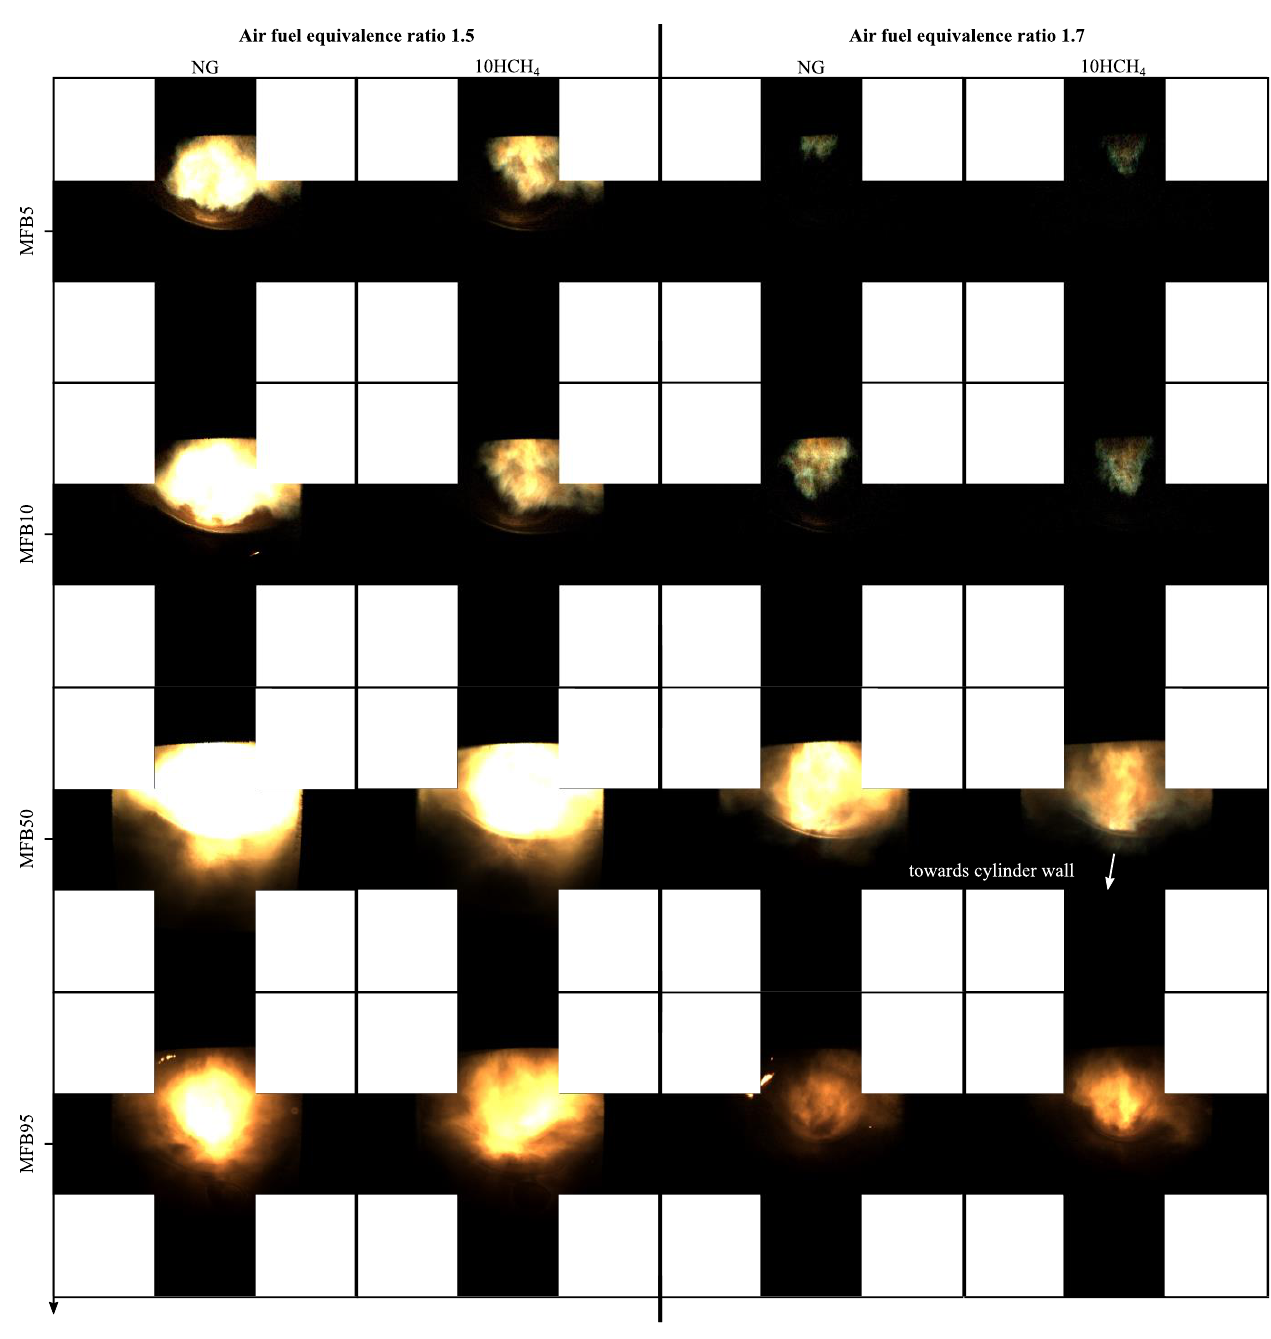
Figure 15. Combustion image series for MFB5, 10, 50 and 95 for the conventional spark plug at 8° CoC and air–fuel equivalence ratio of 1.5 and 1.7. With MFB5, both flames show a reddish portion, which can be an indicator of the formation of water. The center of combustion shows a strong yellow flame,